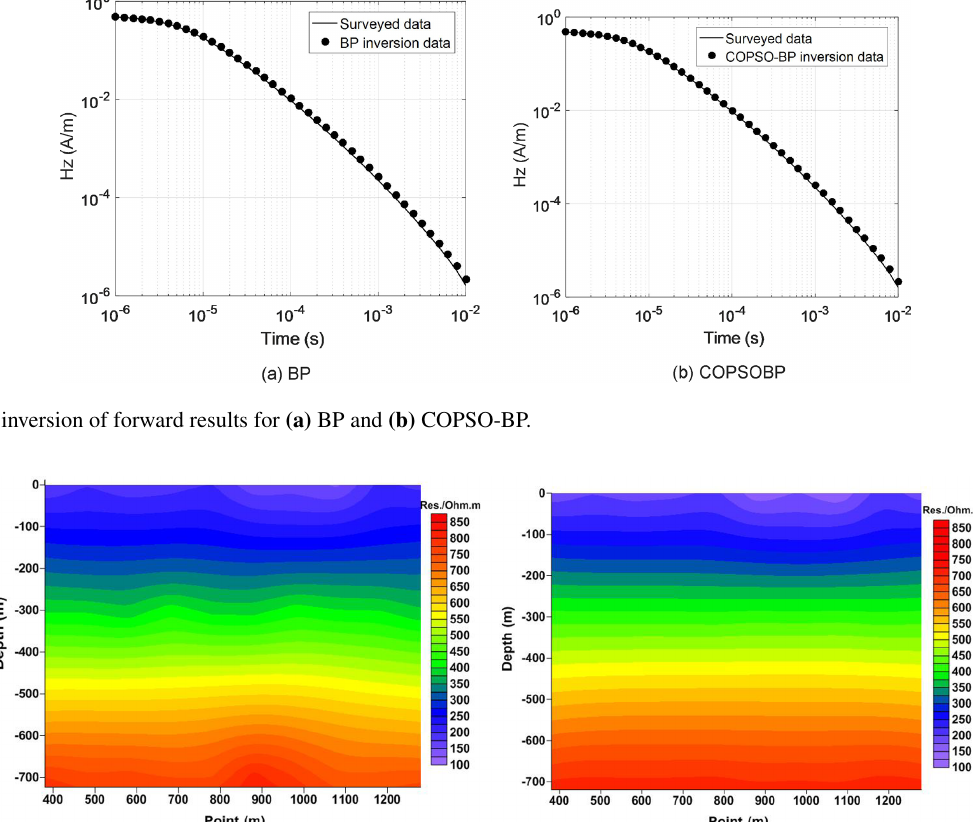
Code availability. The